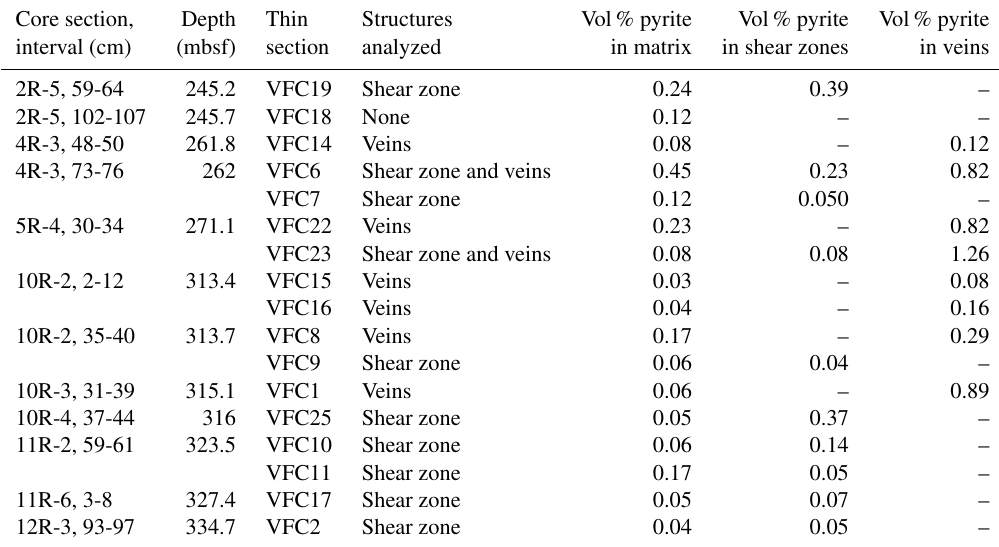
Table 2. Modal proportions of pyrite in deformation bands (shear zones and veins) and in their host matrix deduced from the analysis of optical microscopic pictures. Core section,